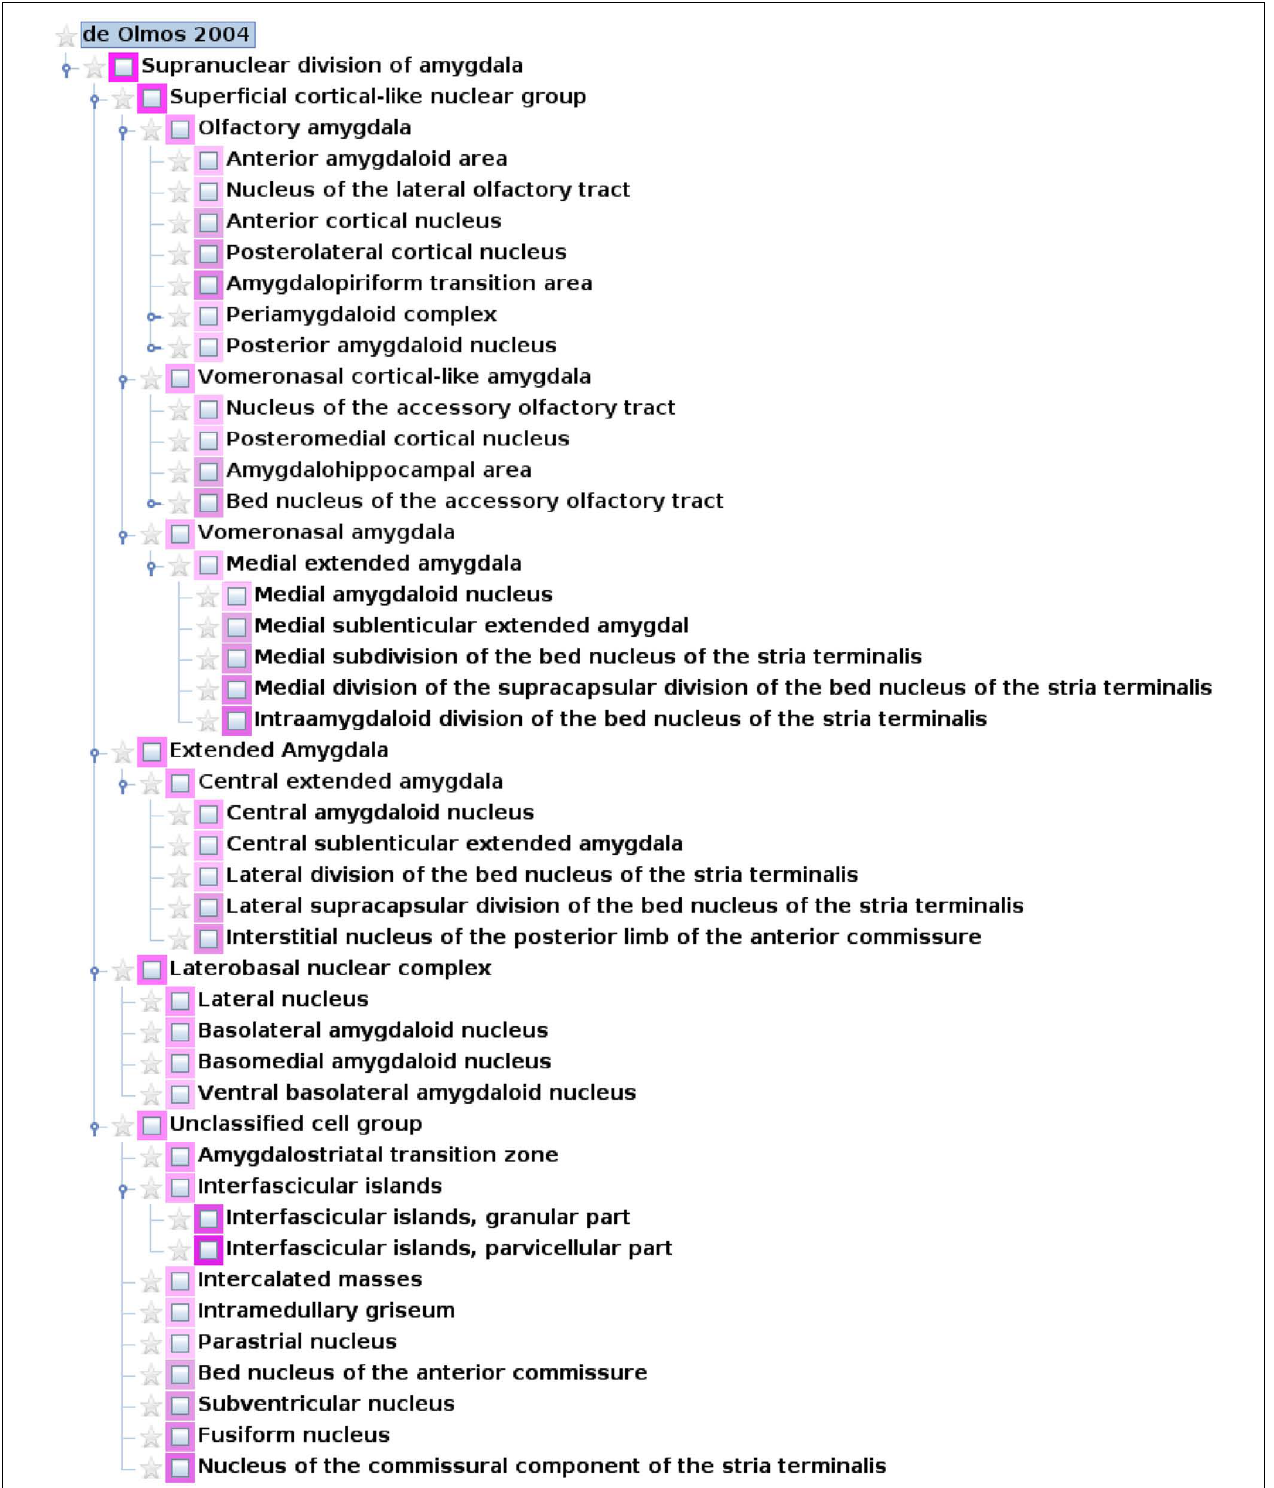
FIGURE 2 |A hierarchical nomenclature of subregions of the rat amygdala based on (de Olmos et al., 2004) has been implemented for the rat connectome project in neuroVIISAS . Only the top levels of the hierarchy are shown. Different intensities of magenta indicate different subregions.